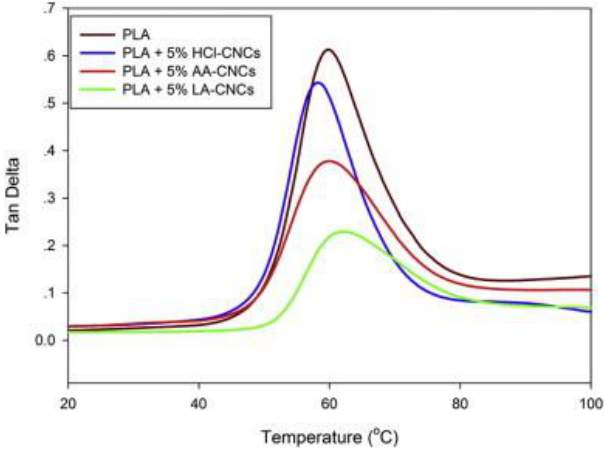
Figure 10. Tan Delta of modified and unmodified CNCs. Reprinted with permission from [52].